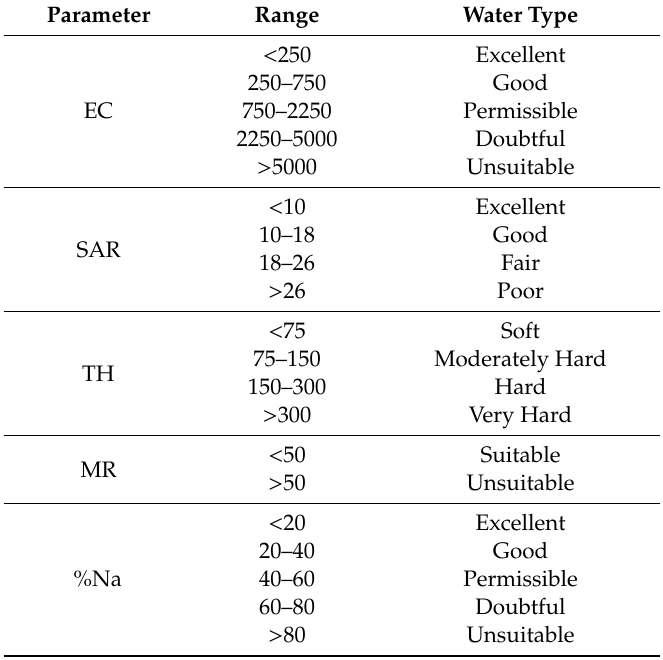
Table 3. Classification of irrigation water types (Source modified by researchers